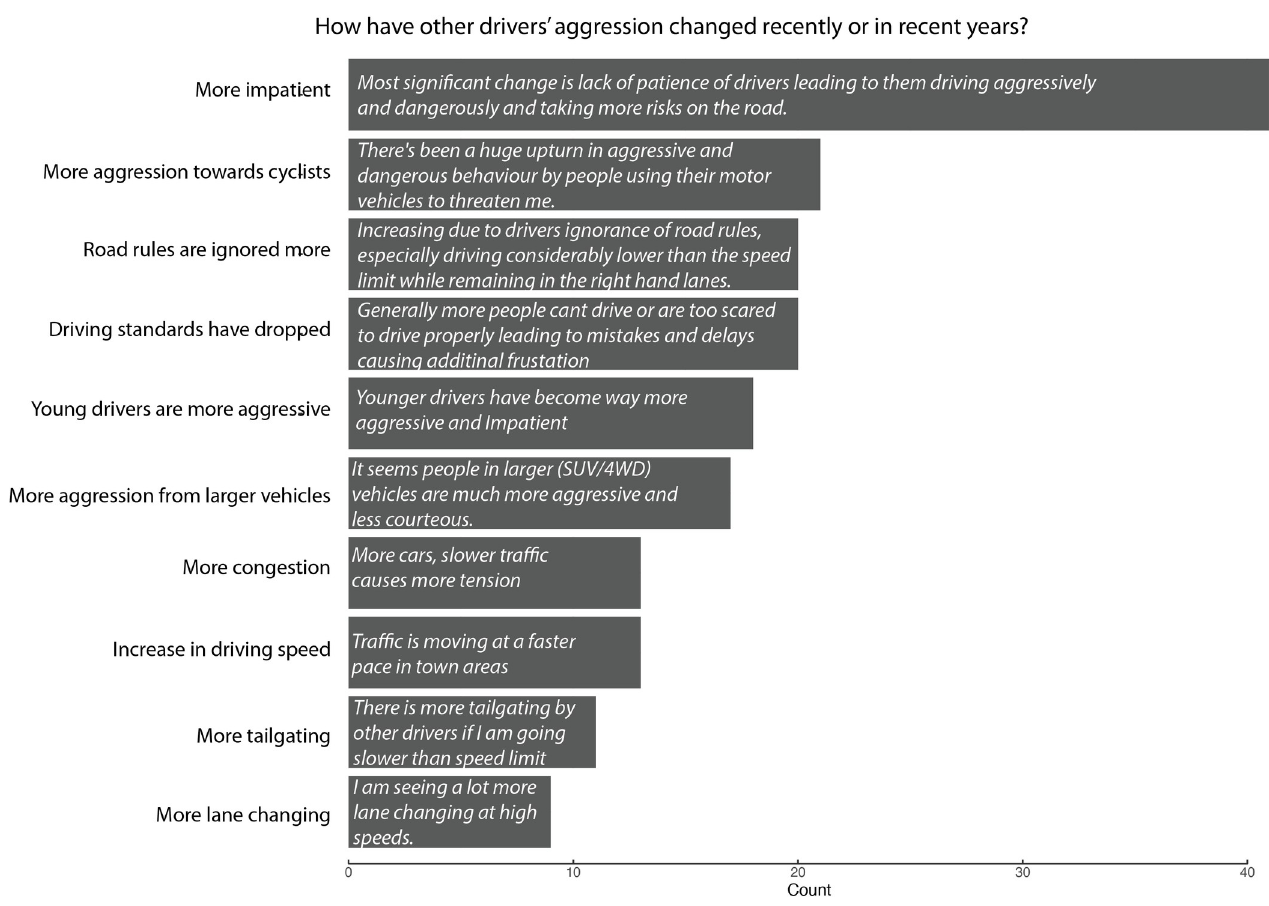
Fig 1. Summary of themes that emerged from coding the text responses to questions regarding changes in aggressive driving over time. No specific time frame was provided for this question. Each theme is ordered by frequency and is presented with an illustrative quote.